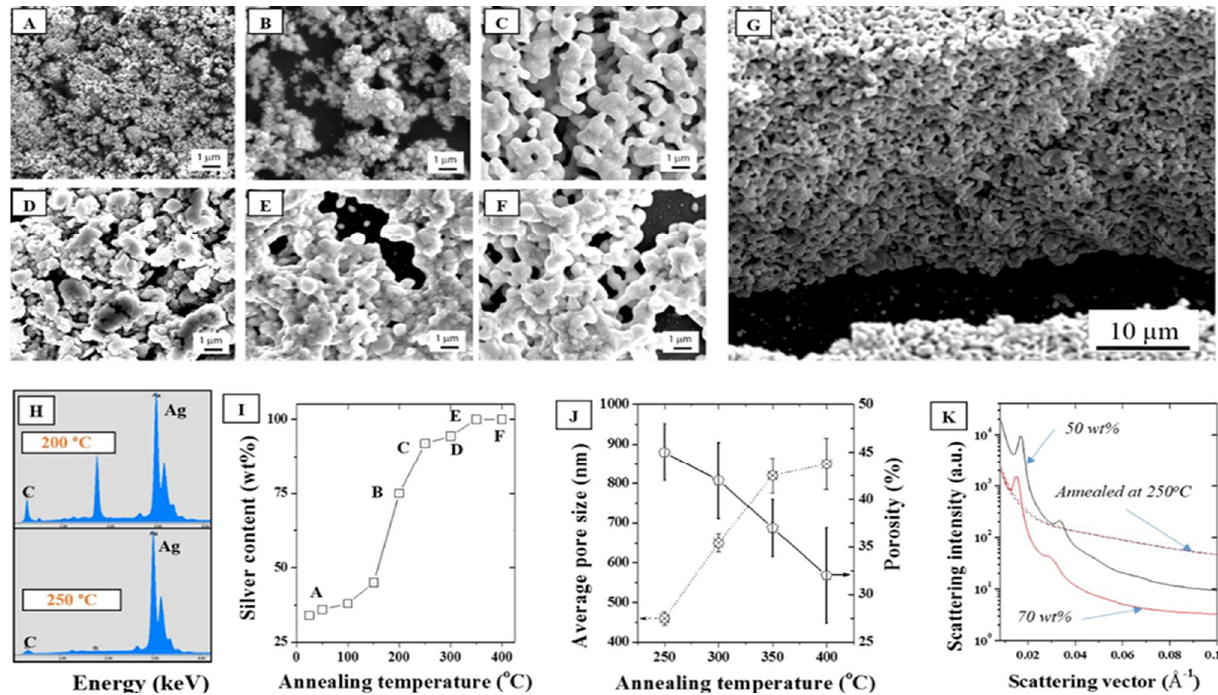
Figure 6. SEMs of a 30 wt % F127 sample in water with 15 wt % silver NPs after annealing in air at ( A ) 25, ( B ) 200, ( C ) 250, ( D ) 300, ( E ) 350, and ( F ) 400 °C, ( G ) Cross section corresponding to ( C ), ( H ) EDS elemental distributions at 200 °C and 250 °C showing a strong reduction of the carbon peak above 250 °C; ( I ) Corresponding silver surface content (EDS); ( J ) Average pore size and porosity determined by SEM analysis following for